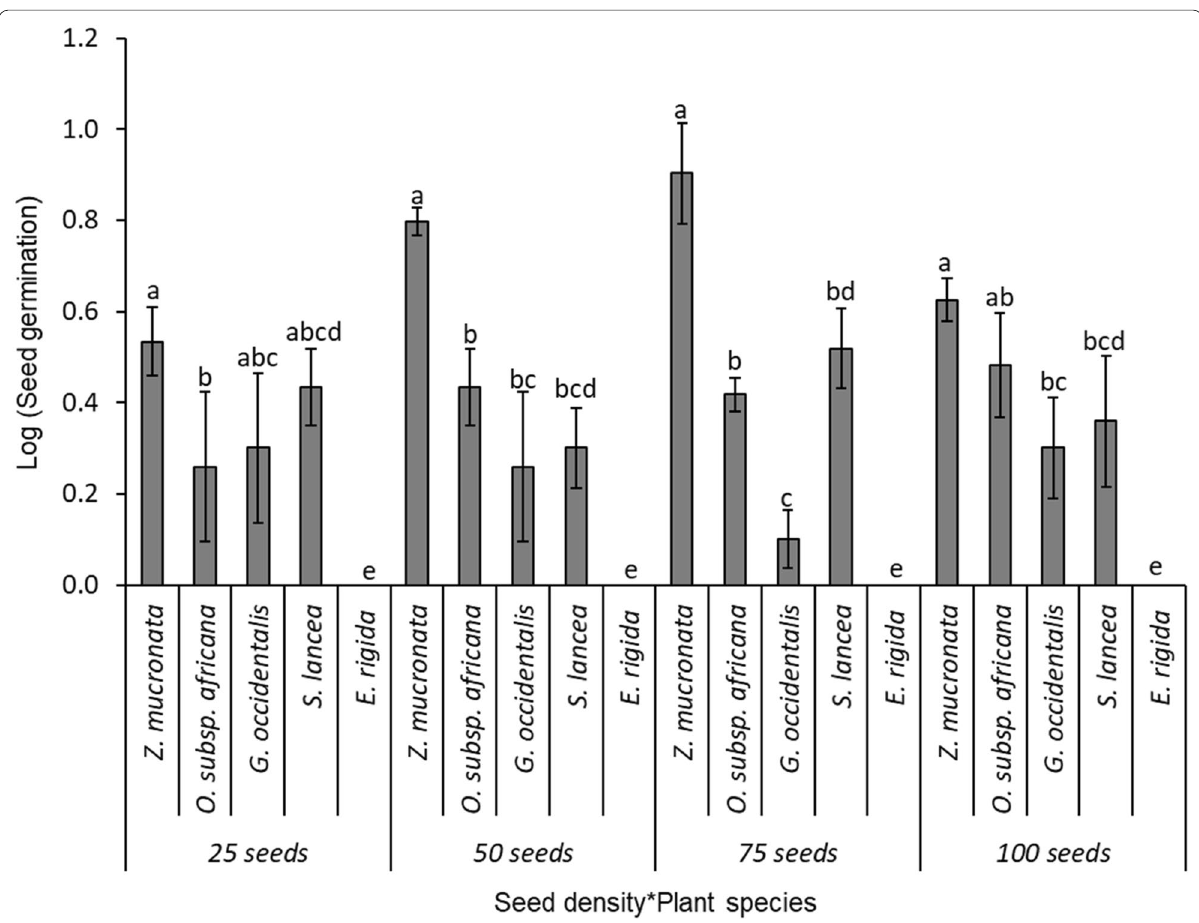
Fig. 7 Mean seed germination for different plant species in competition level 4 between five tree/shrub species: Z. mucronate , O. subsp. africana, G. accidentalis, S. lancea and E. rigida. The error bars represent the standard error of sample mean, and different letters above standard error bar denote